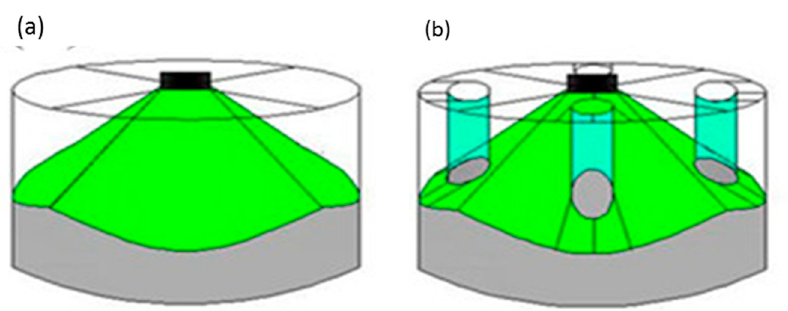
Figure 7. Three-dimensional simulation illustration showing changes of the single domain SmBCO crystallization structure: ( a ) normal sample; ( b ) drilled